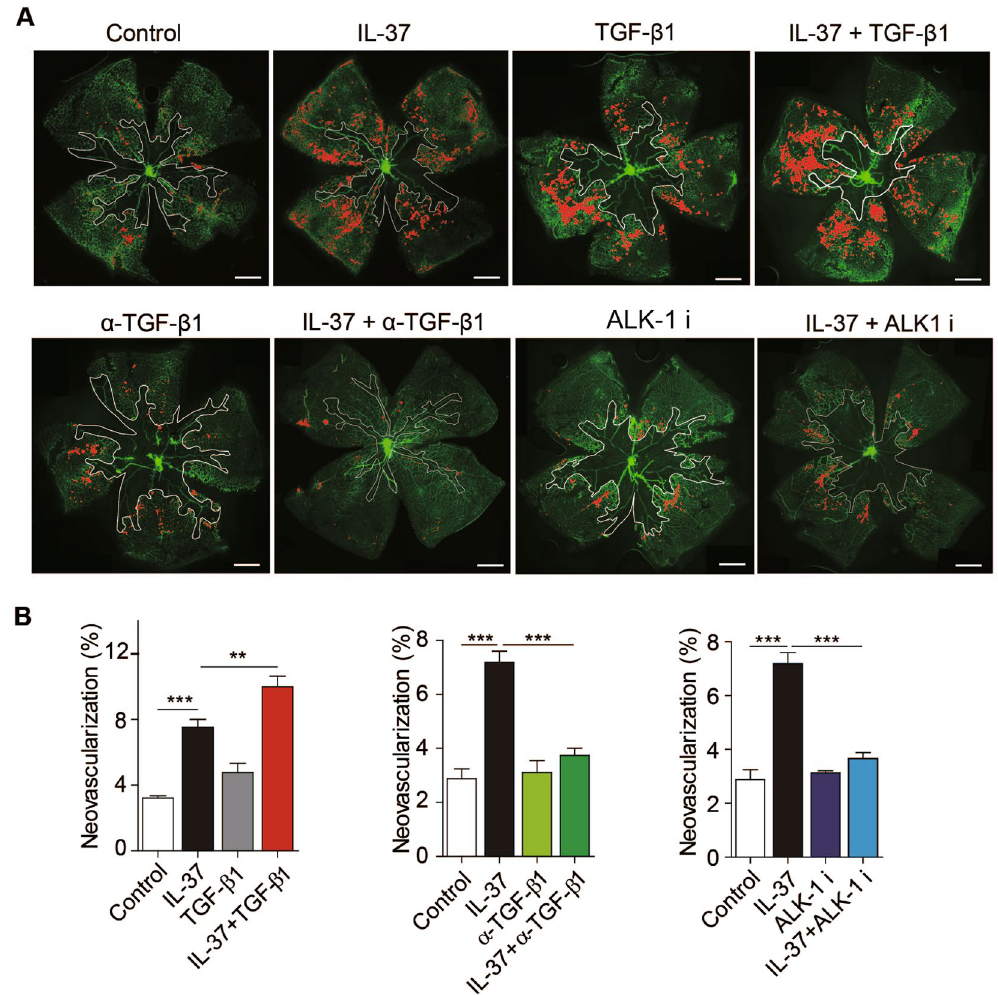
Figure 6. IL-37 promoted neovascularization through TGF- β signaling in OIR model. ( A ) Mice were administrated with 5 ng/g bodyweight IL-37 at postnatal day 12 (P12), P14 and P16 during normoxia phase. For blockade of TGF- β 1 or ALK1, TGF- β 1 neutralizing antibodies was administrated intraocularly at 0.5 μ g per eye and ALK1 inhibitor LDN193189 was administrated intraperitoneally at 2 mg/kg bodyweight during normoxia phase. (n = 10 per group). ( B ) Disordered neovascular growth (tufts) highlighted in red in retina were quantified. Scale bars, 500 μ m (lower magnification). Data are presented as mean ± SEM. * P < 0.05, ** P < 0.01 and *** P <